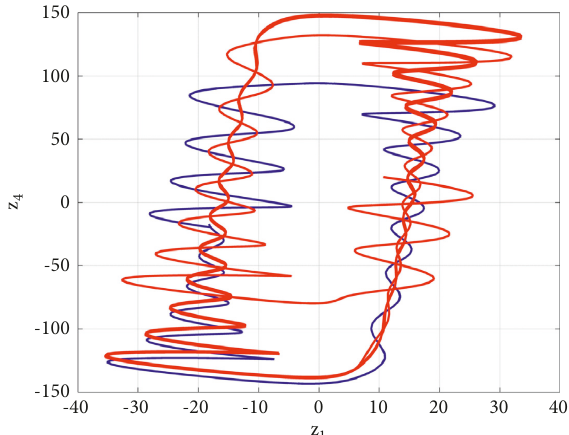
Figure 28: The coexistence of hyperchaotic attractors for system (1) ,z ) coordinate plane , z ) coordinate plane for the choice of pa- projected in the ( z 1 4 1 3 rameters ( a,b, c, d ) � ( 25 , 8 , 65 , 6 ) .